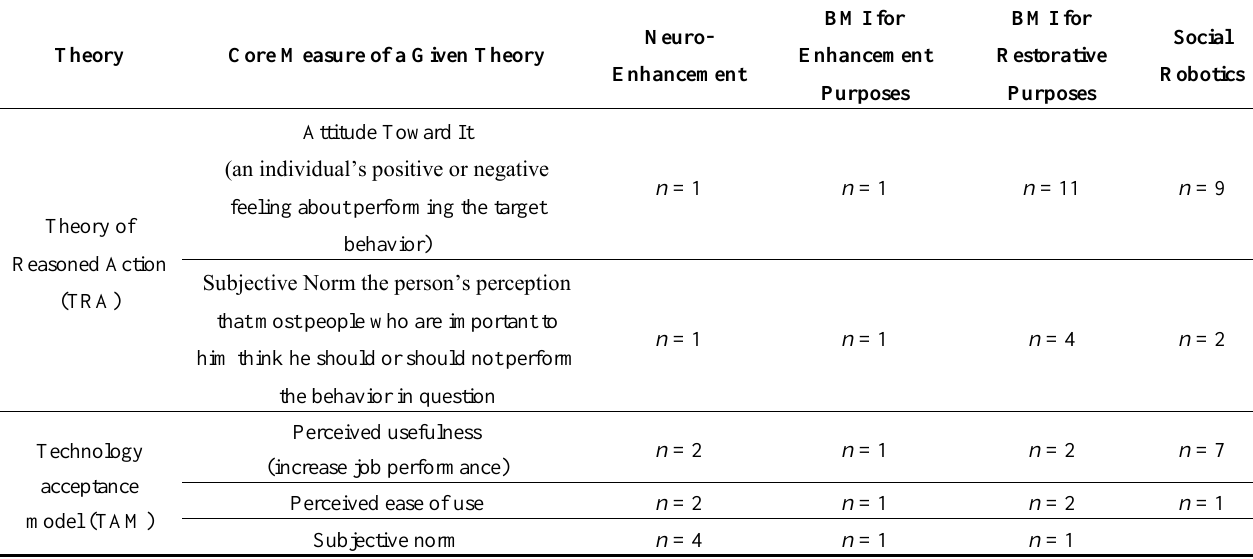
Table 2. Core Measures of technology assessment models covered in the Neuroenhancement, Cognitive Enhancement, Brain Machine Interface and Social Robotics discourse ( n = number of